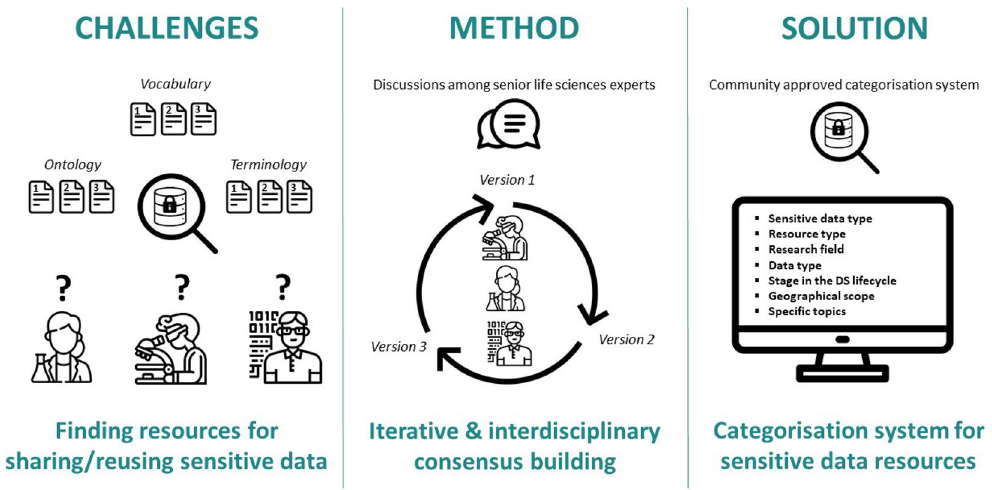
Figure 1. Graphical abstract: Challenges, method and solution.